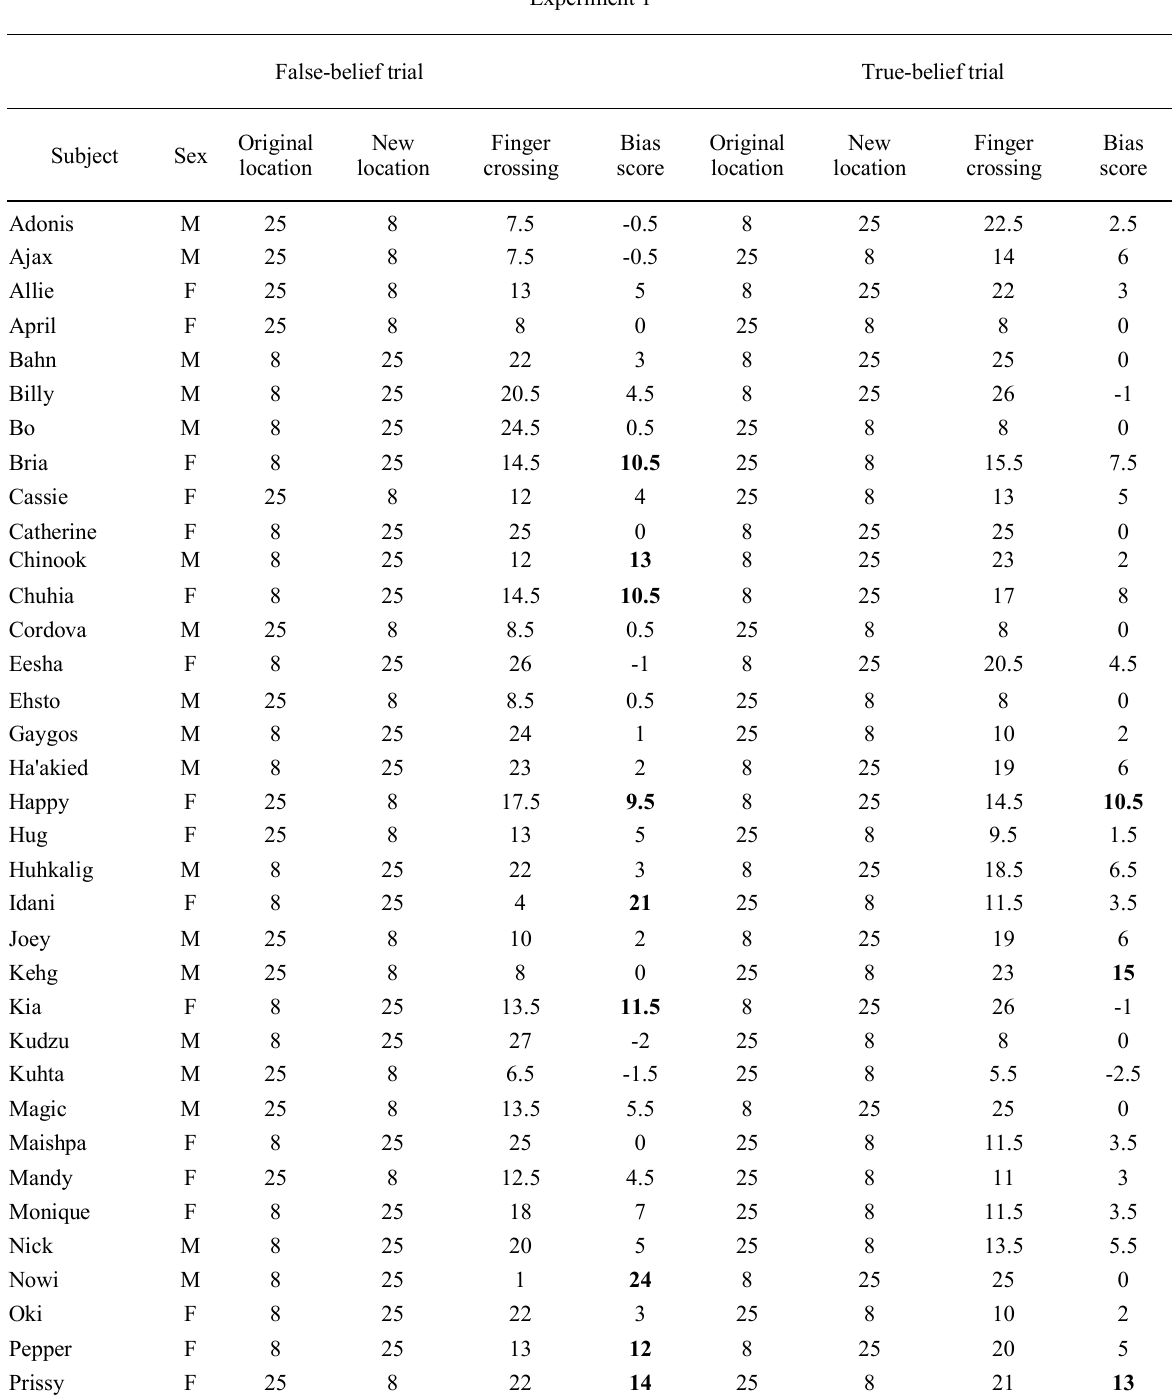
Dataset for Experiment